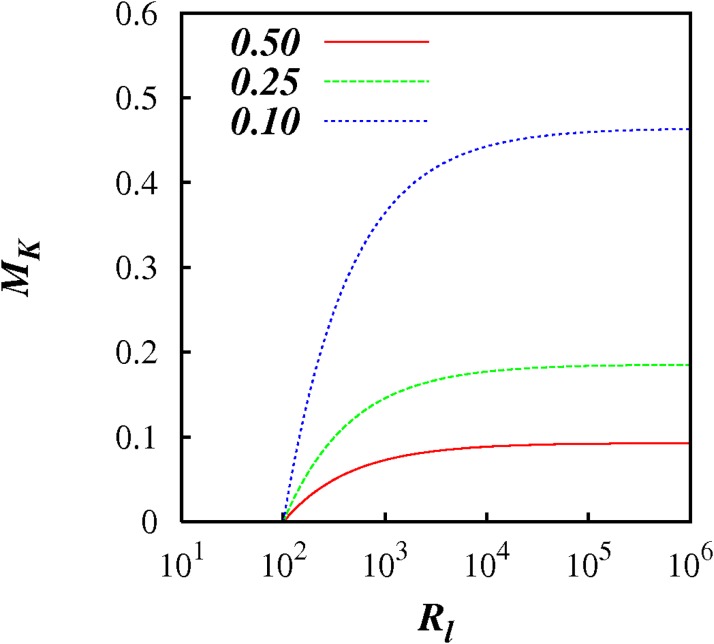
MK against log(Rl), from Eq (40) with p = 5/3, C = 100, and Fl = 0.1, 0.25, 0.5 as indicated.